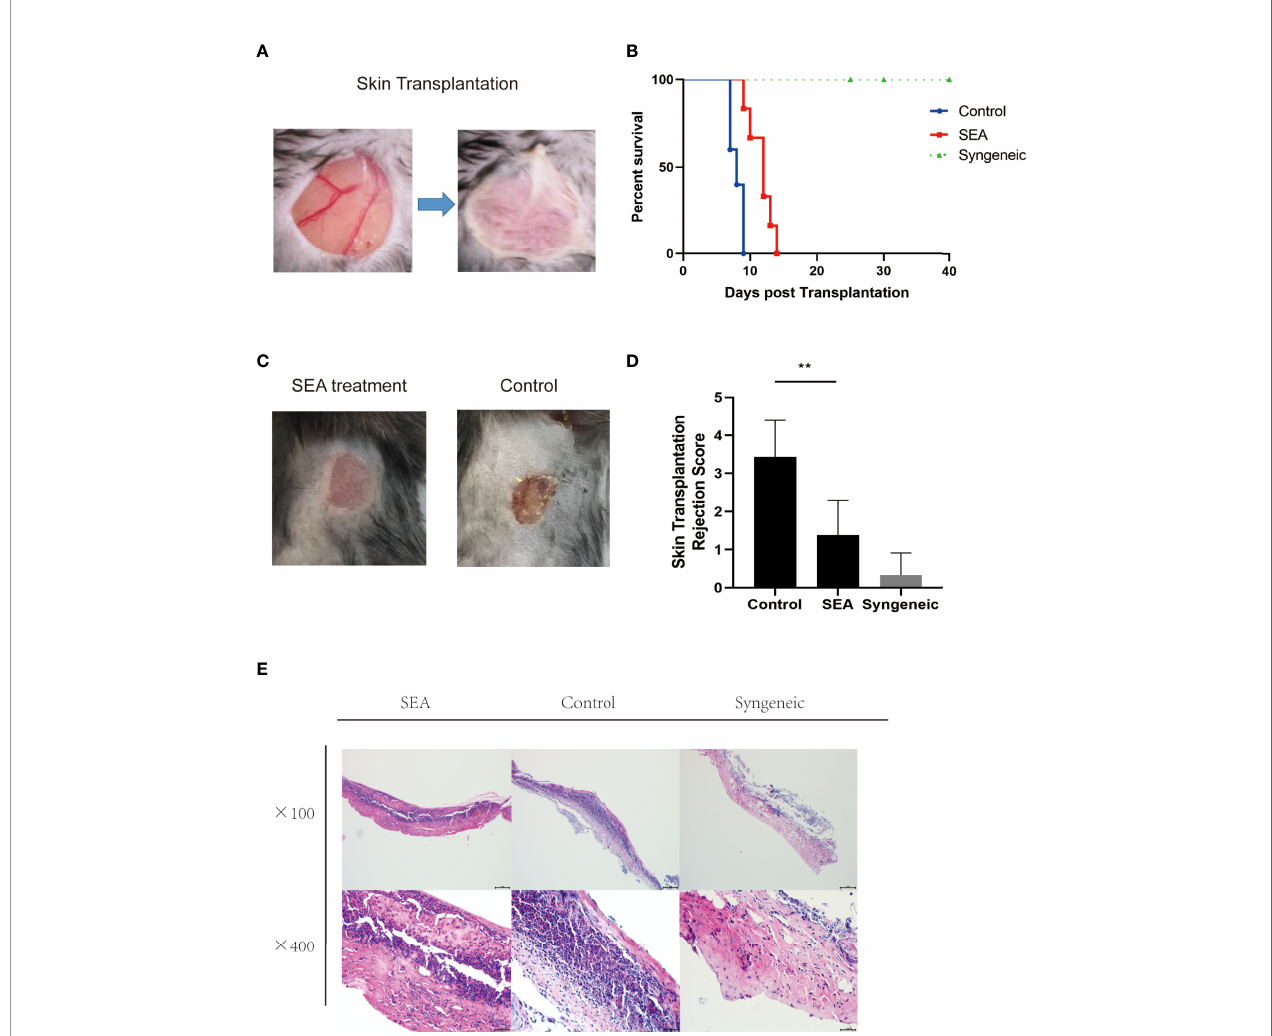
FIGURE 1 | SEA pretreatment can prolong the survival time of mouse skin grafts. (A) In the control group (n=5) has no special treatment, and in the treatment group ( n = 6), each mouse is given SEA 100 m g pretreatment 28 days later (3 times a week, 4 weeks in a row), and the outer ears of BALB/c donor mice were transplanted to the back of C57BL/6 recipient mice. (B) Compared with the control group (8.00 ± 0.36), the treatment group (11.67 ± 0.69) signi fi cantly prolonged the survival time of skin grafts ( p < 0.01). (C, D) On the 9th day after transplantation, there was no obvious in fl ammation, ulcer, and necrosis in the skin grafts in the SEA treatment group. Compared with the control group, the graft rejection score was signi fi cantly lower than that of the control group ( p < 0.01). (E) The pathological changes of the skin grafts were observed on the 7th day after transplantation. Compared with the control group, the low-power and high-power microscopes showed that the neutrophil cell aggregates